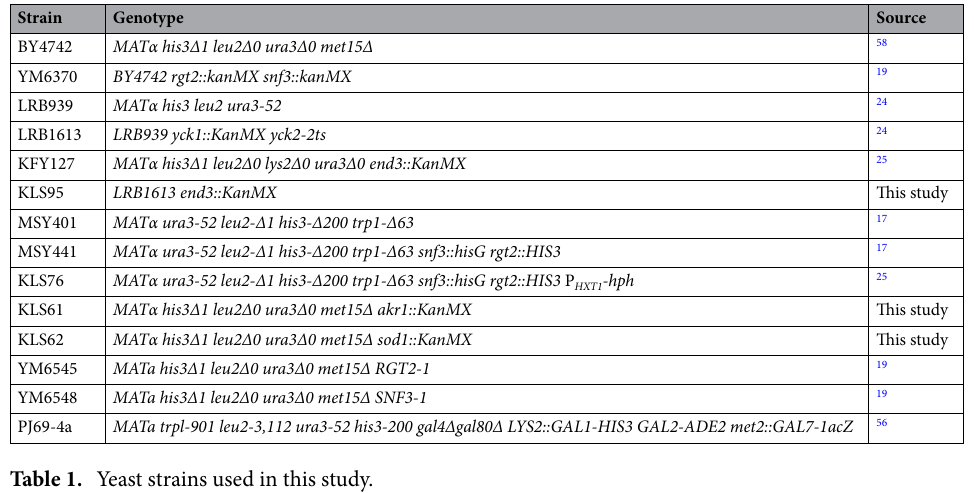
Table 1. Yeast strains used in this